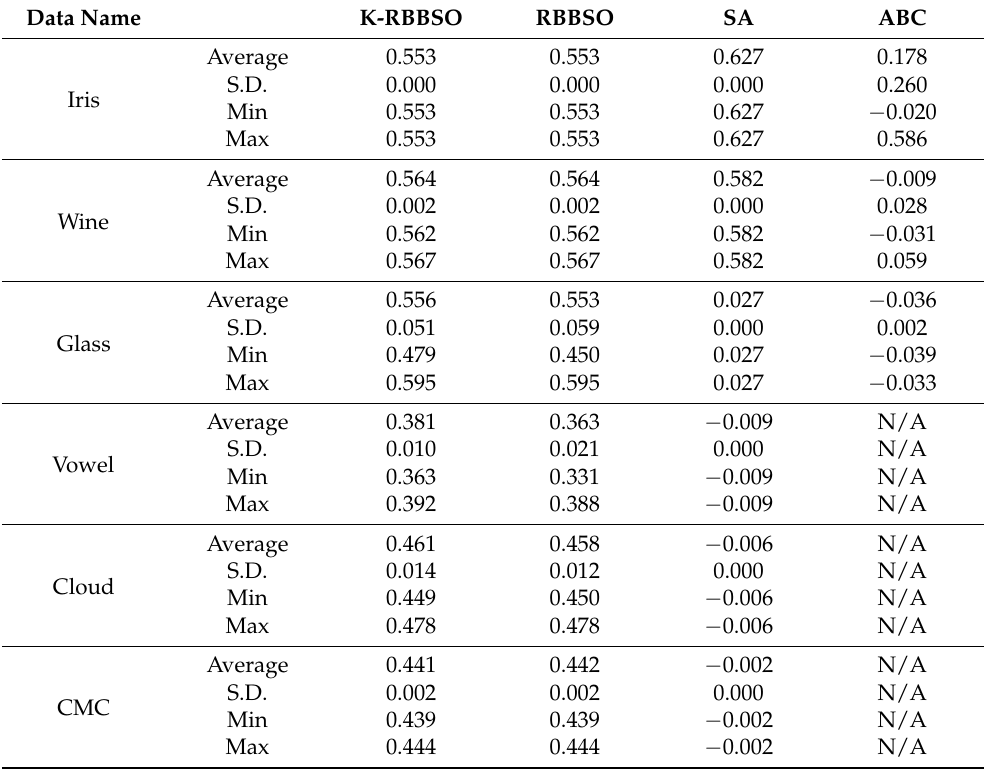
Table 2. Estimated values of the silhouette